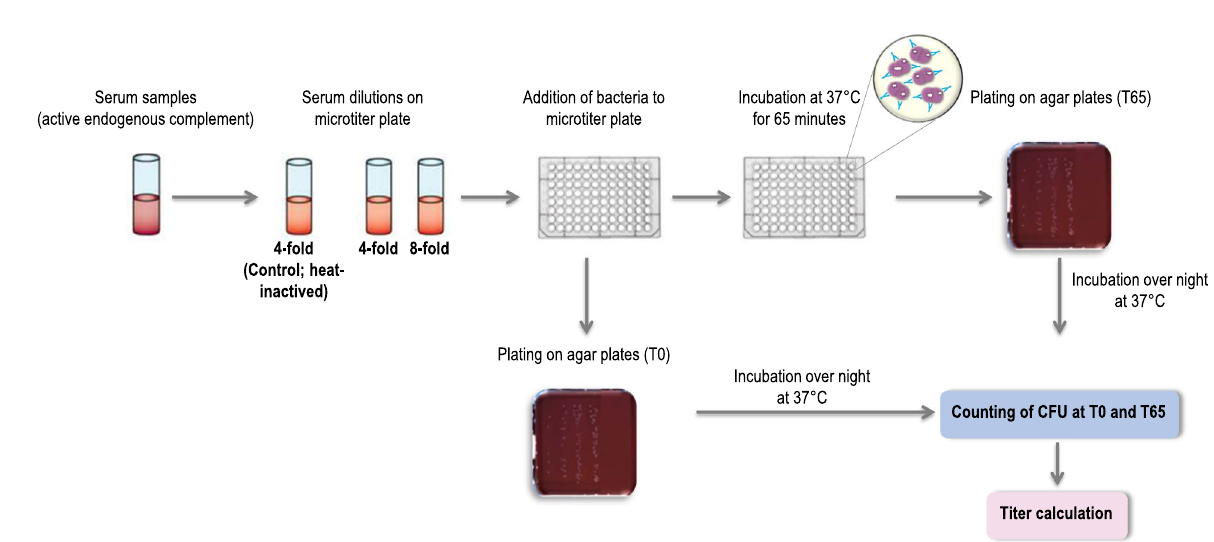
Fig. 1 Enc-hSBA: assay principle. Audioslides on the enc-hSBA assay principle are available on the Figshare repository (https://doi.org/ 10.6084/m9. fi gshare.13547006). Enc-hSBA, serum bactericidal activity assay using endogenous human complement; T65, after 65 min of incubation; T0, time 0; CFU, colony-forming